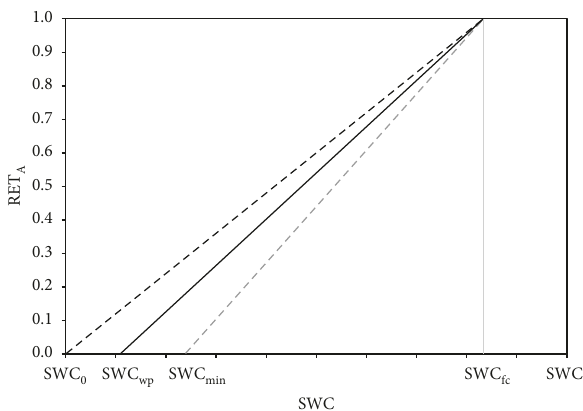
Figure 1: Scheme of the method applied to identify the relationship between SWC and RET A in each study site; SWC 0 coincides with the measured 0, and SWC min , SWC fc , and SWC s are readily de- rivable from the SWC annual evolution, while SWC wp is estimated by optimizing the site soil water balance as described in the